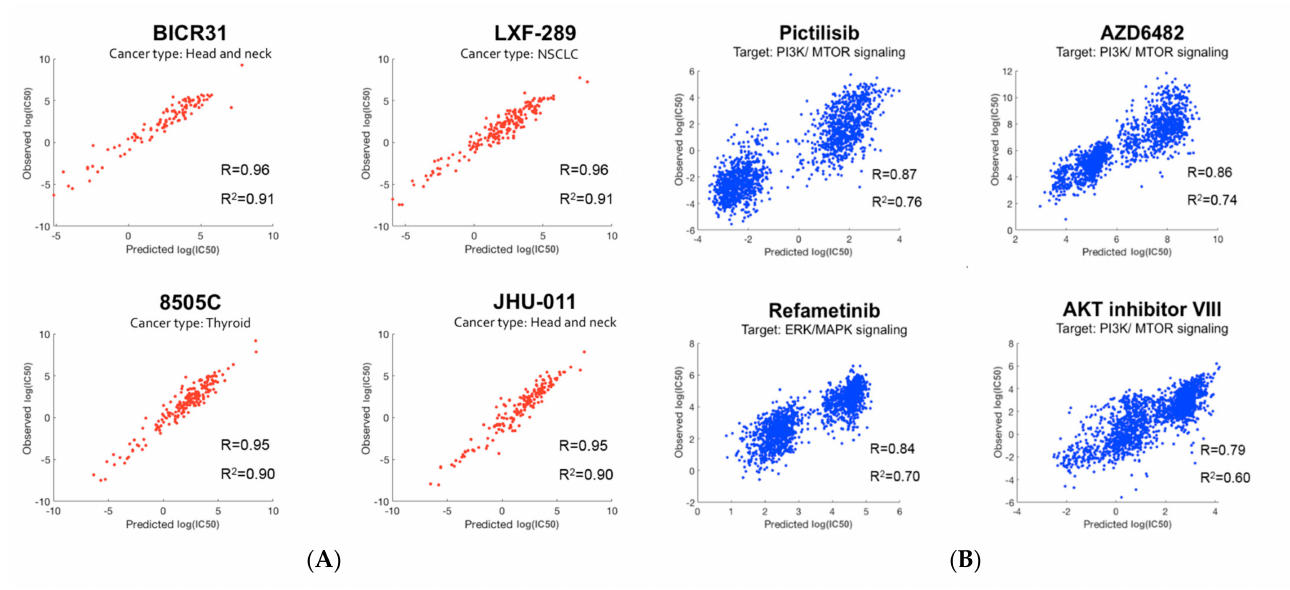
Figure 5. Prediction performance: ( A ) The top four cell lines with the best prediction performance. Cell-line names along with their cancer types are shown. Three out of the top four cell lines belong to head and neck (including thyroid) cancer; ( B ) The top four drugs with the best prediction performance. Drug names along with their targeted pathways are shown. Three out of the top four drugs target the PI3K/mTOR signaling pathway.